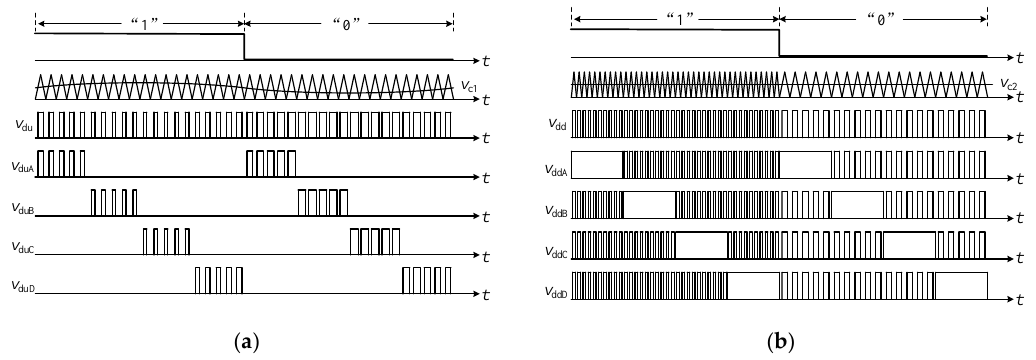
Figure 7. Driving signals waveforms of four-phase Switched Reluctance Drive (SRD): ( a ) driving signals of upper devices for 4 phases and ( b ) driving signals of lower devices for 4 phases.